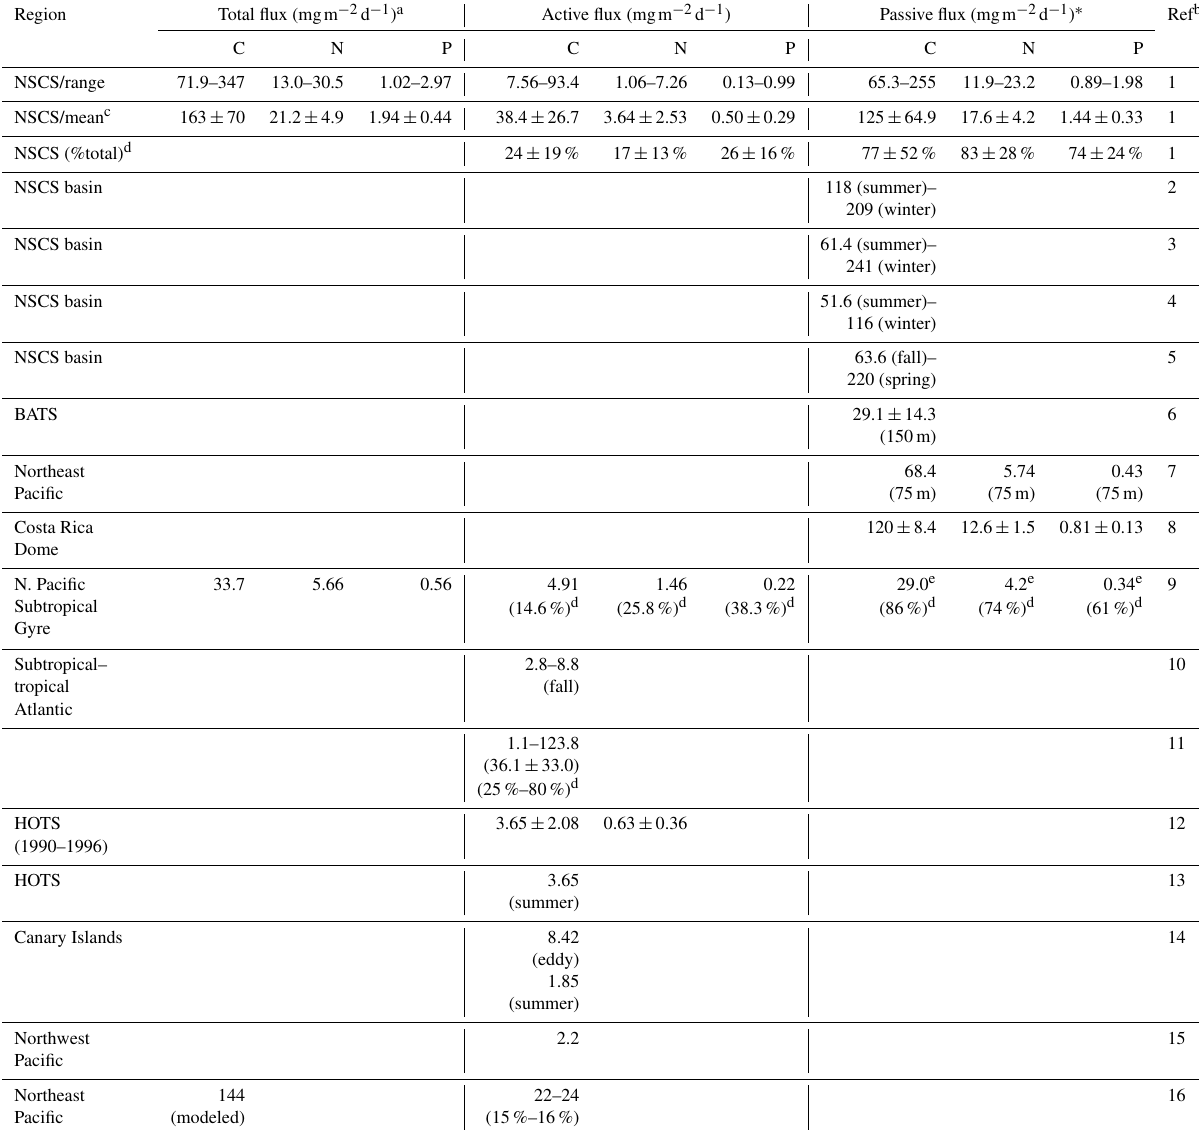
Table 4. Summary and comparison of estimated active, passive (flux at a depth of 100m), and total vertical fluxes of carbon, nitrogen, and phosphorus in NSCS and other